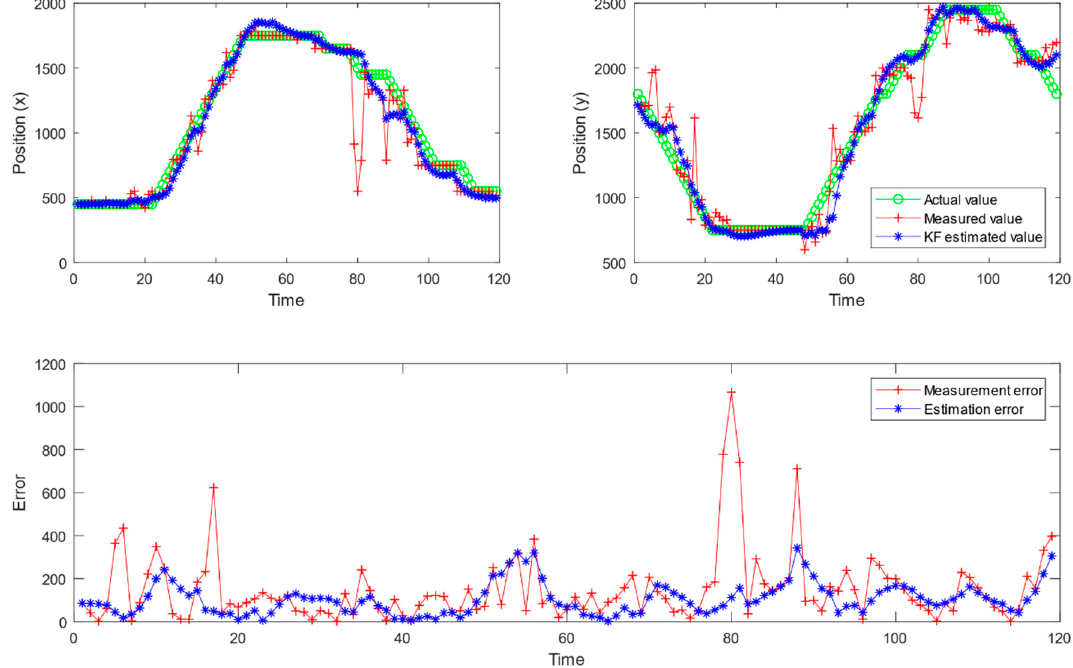
Figure 3. Graphical output of the implementation of Algorithm 4. (The errors are measured in the units of the used coordinate system, with 50 units corresponding to the distance of 1 m).